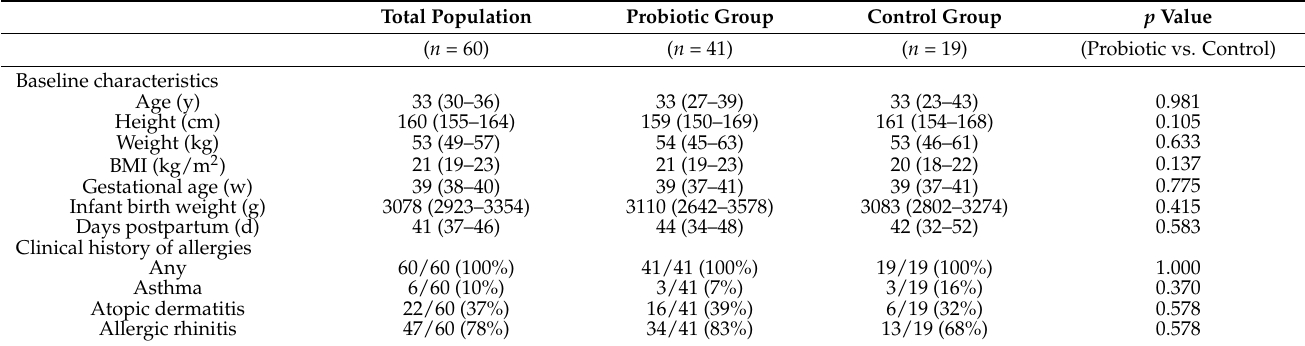
Table 2. Baseline characteristics of the study